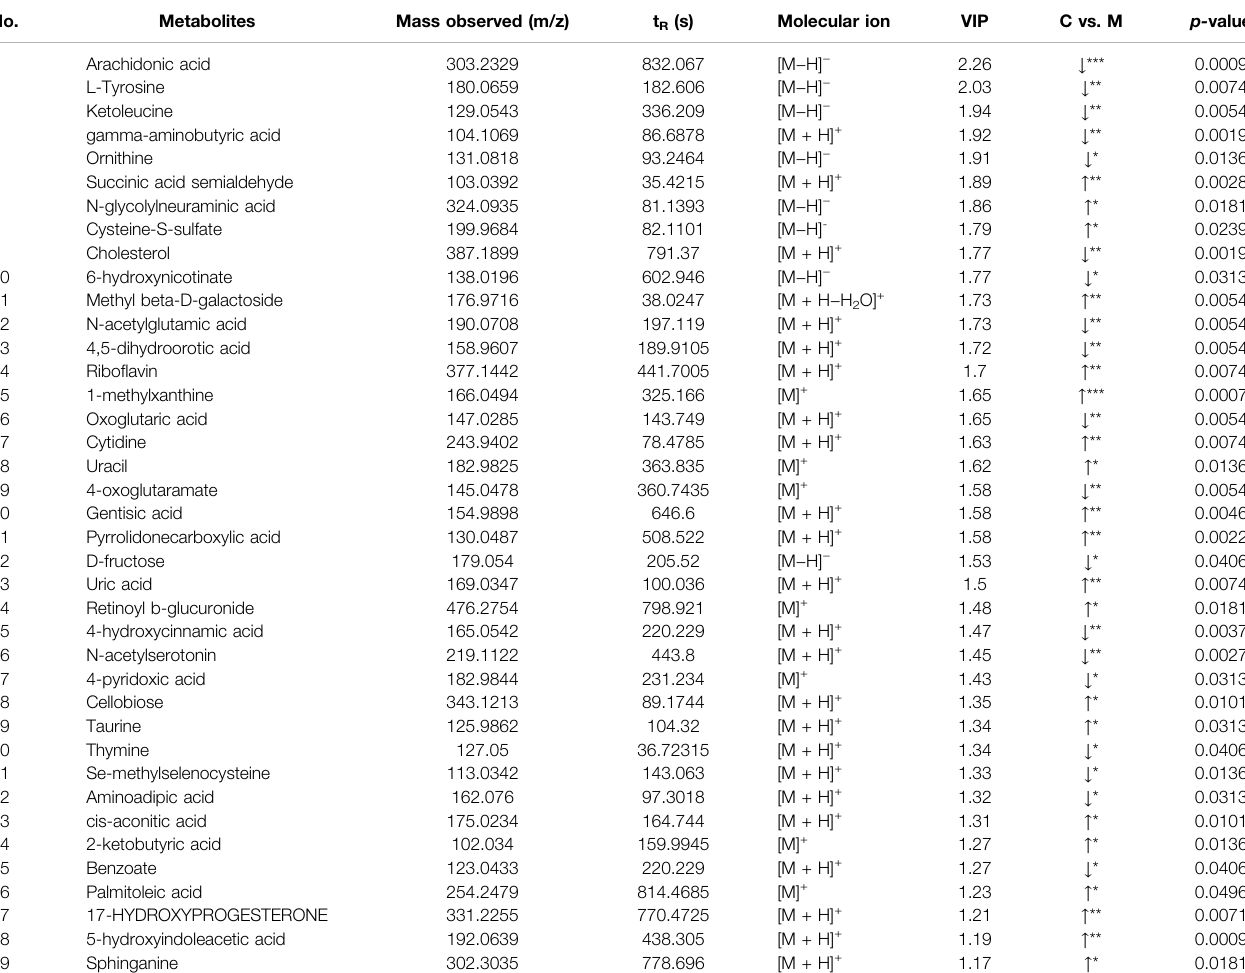
TABLE 1 | Differential metabolite identi fi cation results between normal control group and model group.